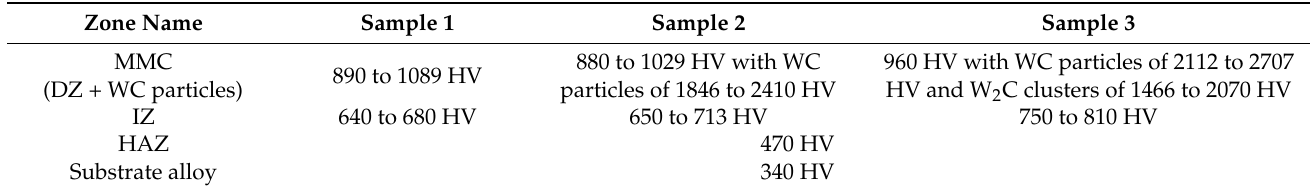
Figure 19. Microhardness variations in the deposition zone for ( a ) sample 2 and ( b ) sample 3. Table 5. Summarized microhardness data of samples 1, 2, and 3.